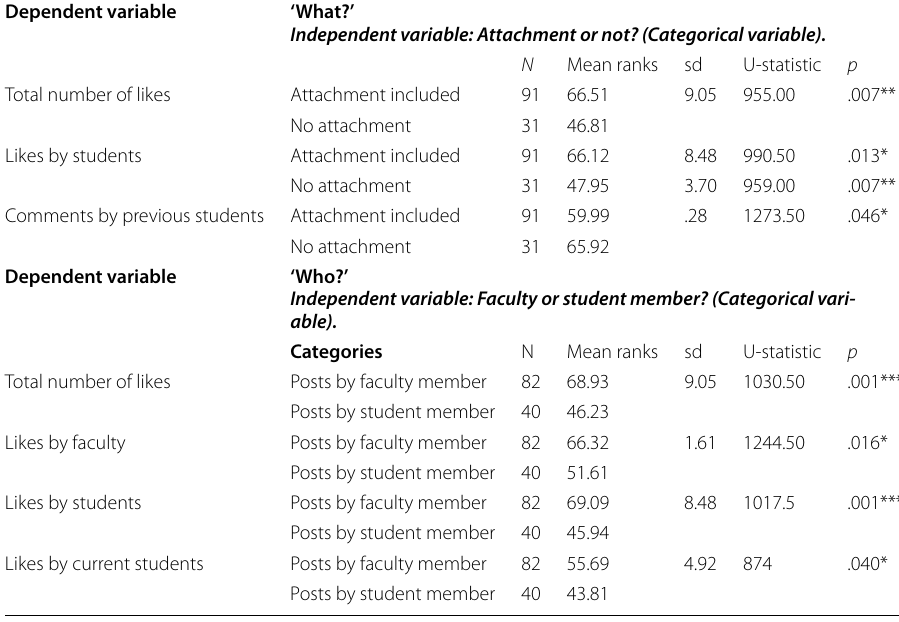
Table 3 Significant results of Mann-Whitney U tests. Only significant results are shown